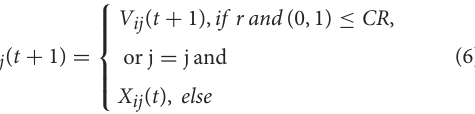
FIGURE3 The optimization process of DE.